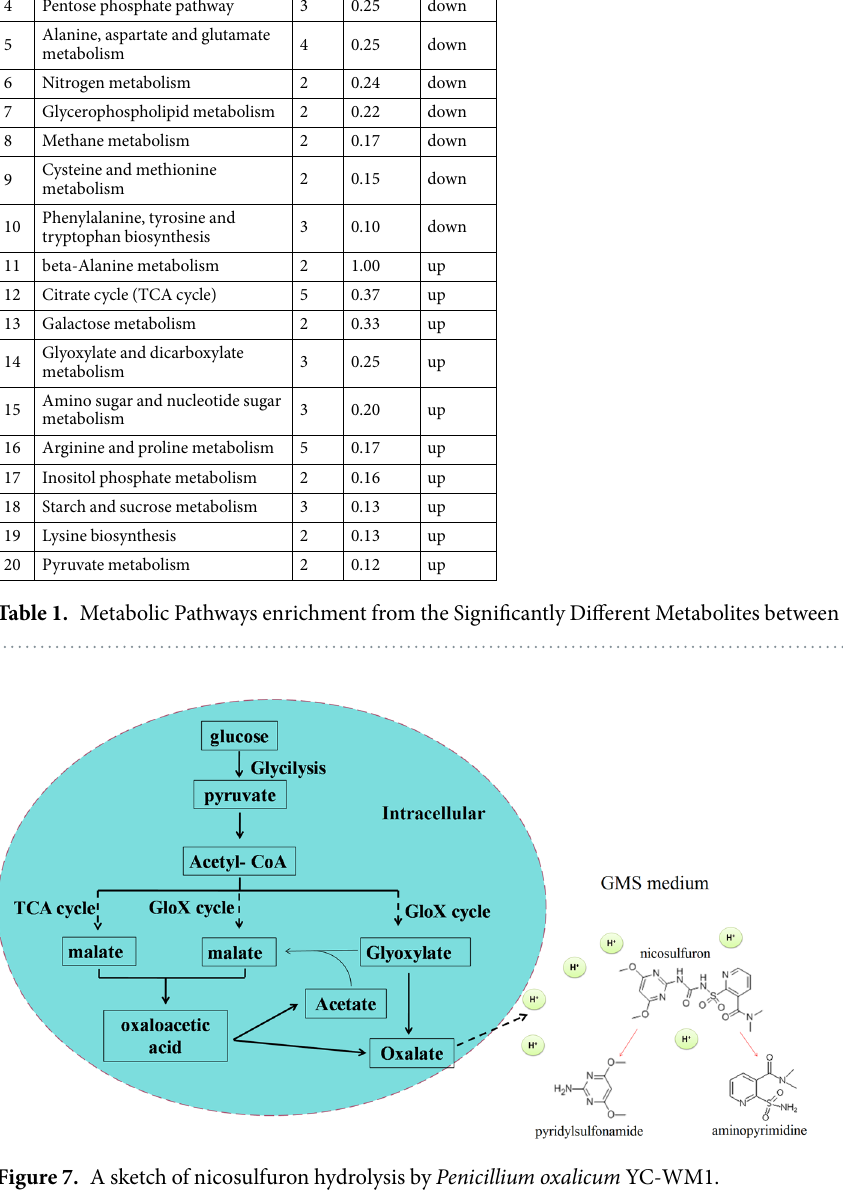
Figure 7. A sketch of nicosulfuron hydrolysis by Penicillium oxalicum